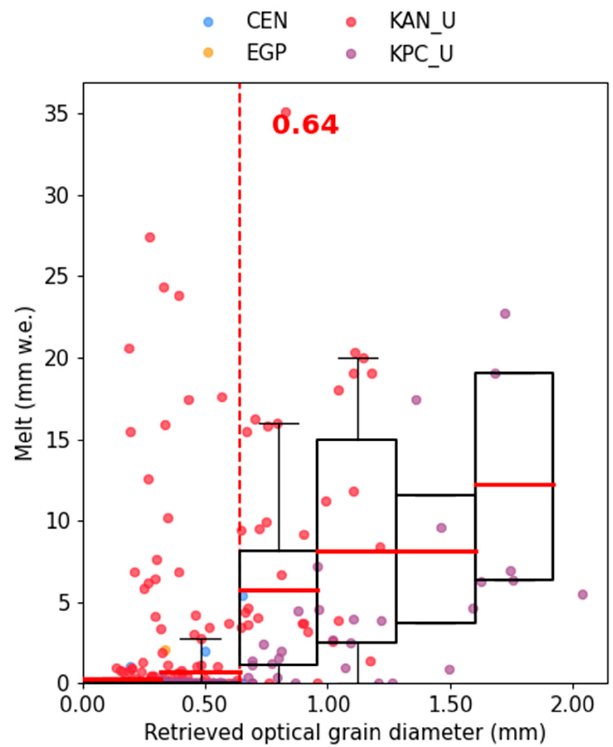
Figure 5. Daily melt calculated at the PROMICE AWSs and the retrieved snow optical grain diameter. Boxplots present statistics for 0.32 mm wide bins of optical grain diameter. The optical grain diameter threshold for melt detection is the dashed red line. In each boxplot, the whiskers represent the 5th and 95th percentiles, the edge of the box the 25th and 75th percentile and the solid red line represents the mean.